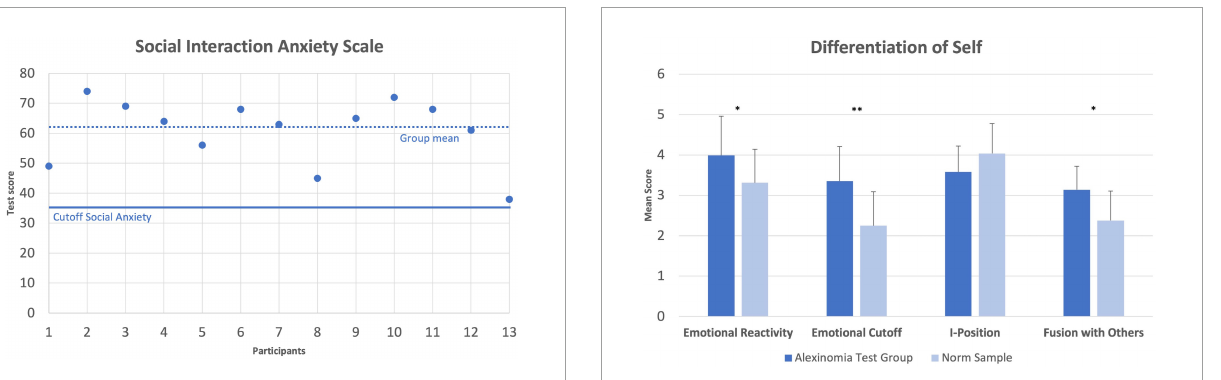
FIGURE3 Differentiation of Self Inventory (DSI). Comparisons of group means in the DSI. Error bars indicate 1 SD. * p < 0.05, ∗∗ p <